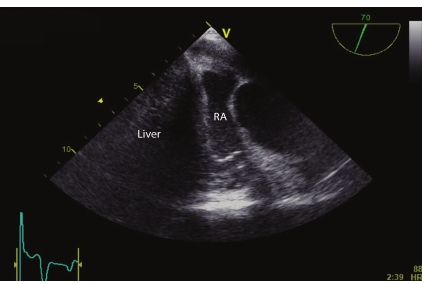
Figure 3: ME image obtained at 70 degrees to better visualize the liver compressing the right atrium (RA) (see associated Supplemen- tal Digital Content